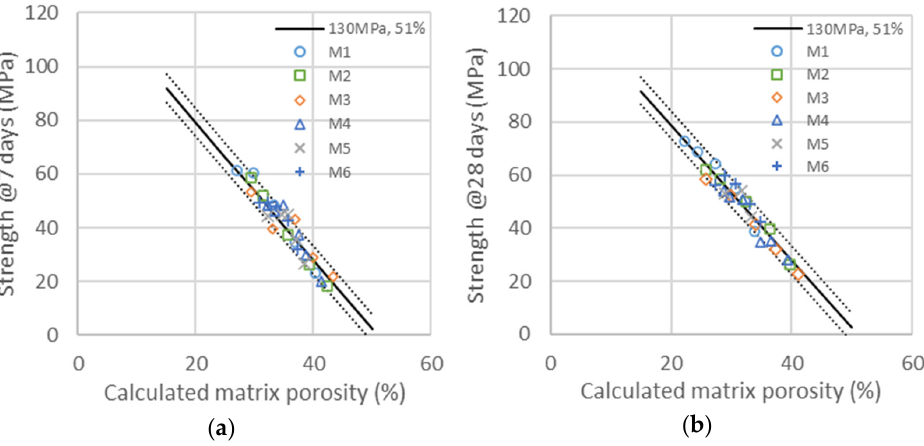
Figure 6. Compressive strengths for the six different additions of metakaolin are presented in Table 7 at 7 ( a ) and 28 days ( b ) as a function of the calculated porosity. The continuous line is the same as that in Figure 3, corresponding to the linear evolution of compressive strength with porosity, as explained in Equation (3) with 𝜎 (cid:2868) = 130 𝑀𝑃𝑎 and 𝜙 (cid:3040) = 51% . The dotted lines are a variation with = 130 MPa and φ m = 51%. The dotted lines are a variation with ± 4% of both ±4% of both 𝜎 (cid:2868) and 𝜙 (cid:3040) . in Equation (3) with σ 0 σ 0 and φ m